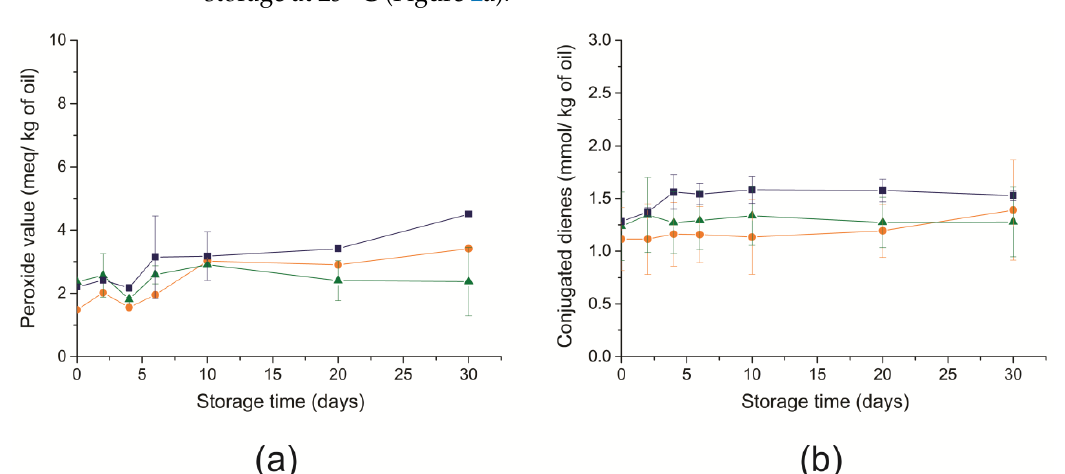
Figure 2. ( a ) Peroxide value (meq/kg of oil) and ( b ) conjugated dienes (mmol/kg of oil) for the spray-dried ( ), freeze-dried ( ), and non-encapsulated RCO ( ) over 30 days of storage at 25 °C.